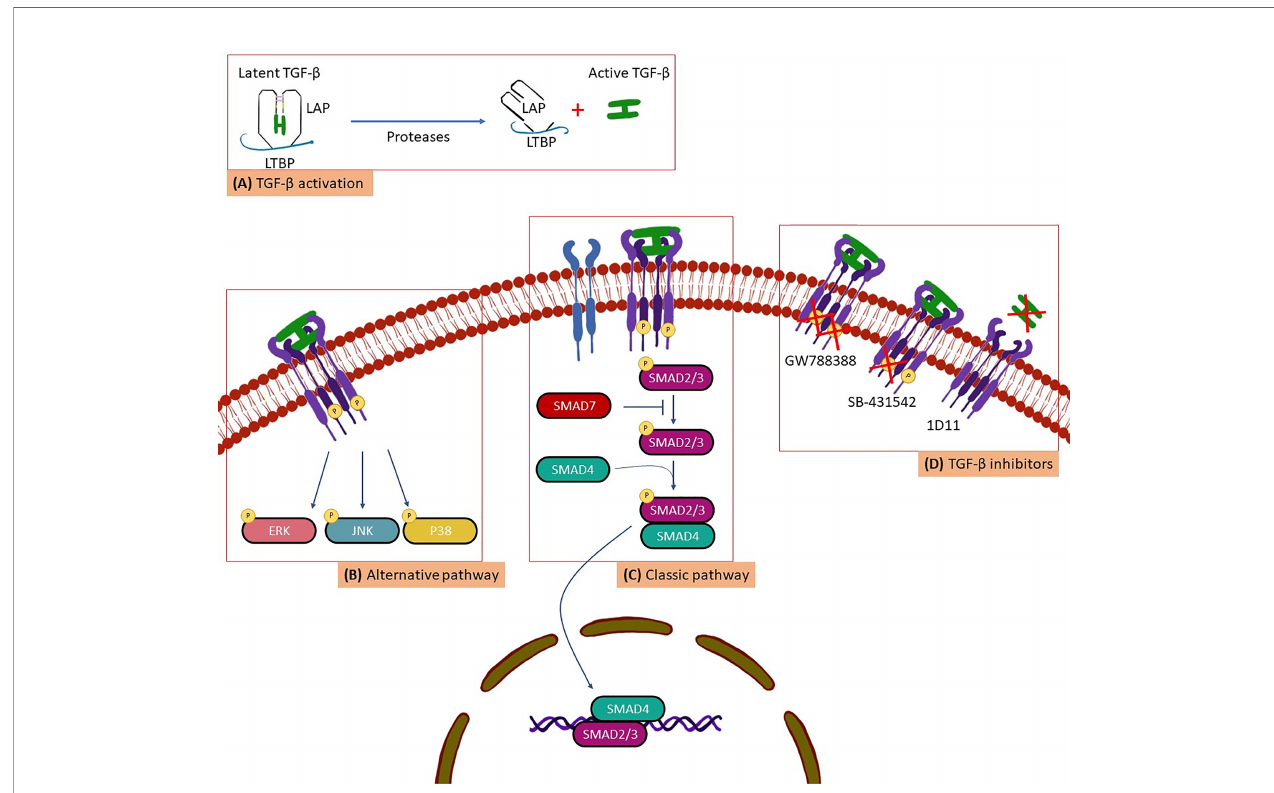
FIGURE 1 | A scheme for (A) TGF- b activation, (B) alternative pathway, (C) Classic pathway and, (D) TGF- b